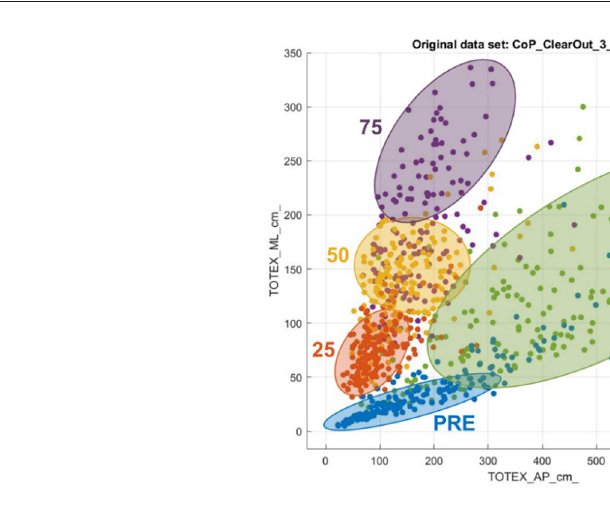
FIGURE6 Total CoP movement in anterior-posterior and medio-lateral direction.